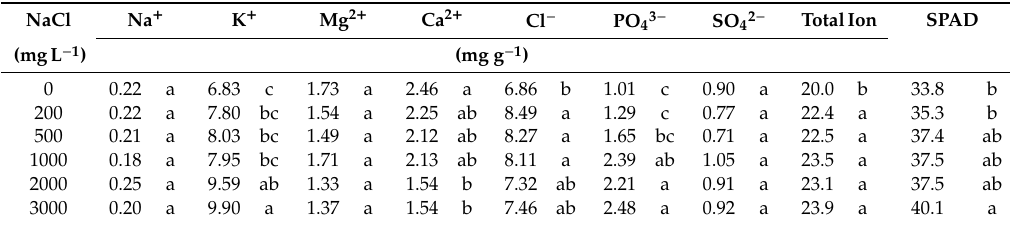
Table 6. E ff ects of NaCl levels in irrigation water on leaf ion composition.